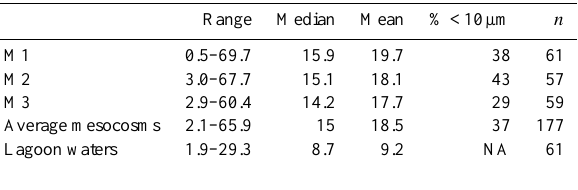
Table 1. N 2 fixation rates (nmolNL − 1 d − 1 ) measured in the meso- cosms and in lagoon waters. Table shows the range, median, mean, contribution of the <10µm fraction to total rates (%), and number of samples analyzed ( n ). NA – not